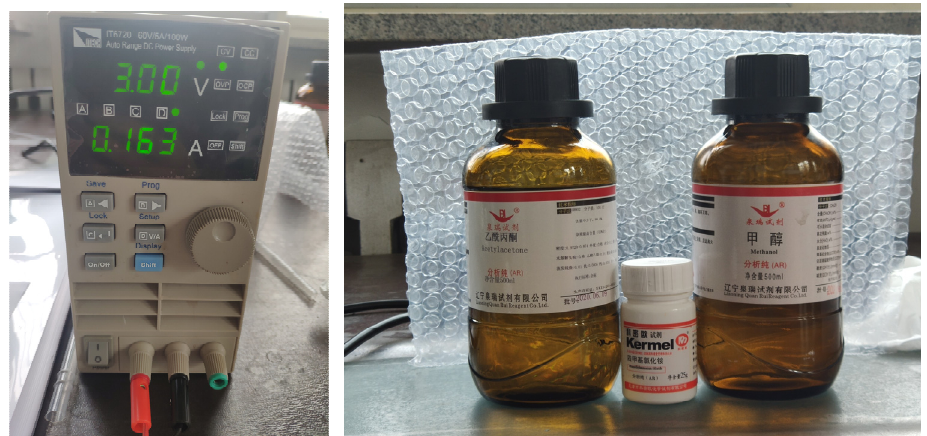
Figure 1. Electrolytic power supply (IT6702) and electrolytic reagent.